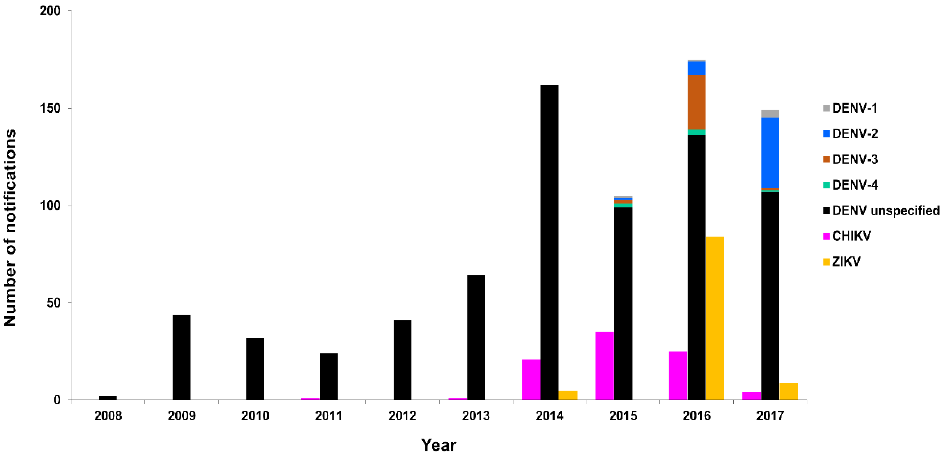
Figure 7. Notified cases by year, New Zealand (NZ), 2008 – 2017. Number of notified confirmed DENV 1 – 4, CHIKV, and ZIKV cases reported in NZ by year, 2008 – 2017 [70].